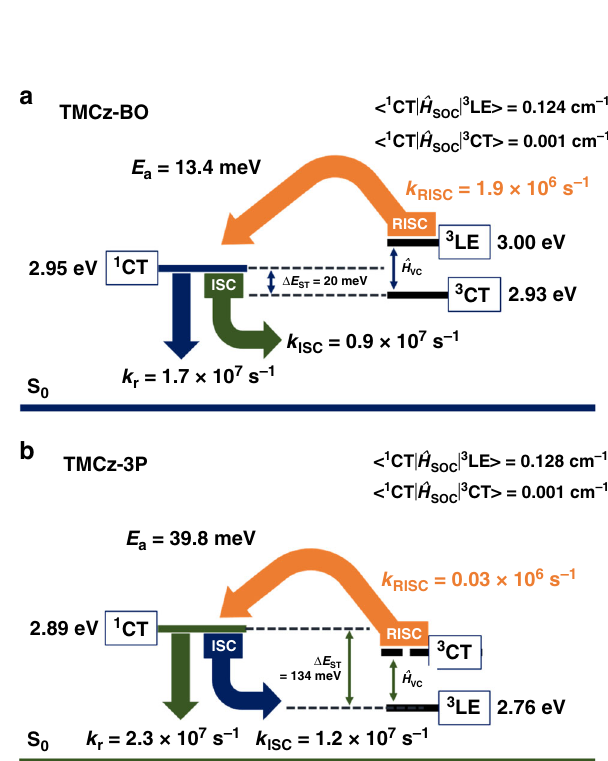
Fig. 5 Schematic illustration of plausible TADF mechanisms. a Decay and upconversion processes in TMCz-BO and b TMCz-3P . The energy levels and rate constants were estimated using 30 wt% doped fi